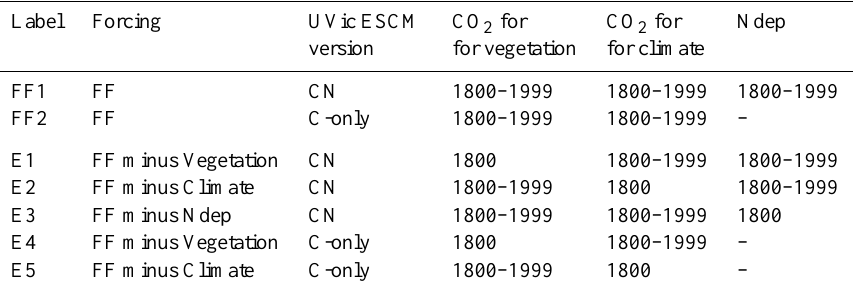
Table 5. Description of the UVic ESCM experiments and the forcings used. “FF” are the fully forced simulations and “E” are the experimental simulations in which the forcings are modified. In the forcing column, “FF” indicates a fully forced model, using transient CO 2 concentration for the vegetation and climate and N deposition, “FF minus Vegetation” means that the CO 2 concentration for the vegetation is held constant, “FF minus Climate” means that the CO 2 concentration for the climate is held constant and “FF minus Ndep” means that the N deposition is held constant. “CN” indicates the use of UVic-CN and “C-only” indicates the use of UVic C-only, “CO 2 for the vegetation/climate” gives the year or period that is used and Ndep gives the year or period of natural and anthropogenic N deposition.